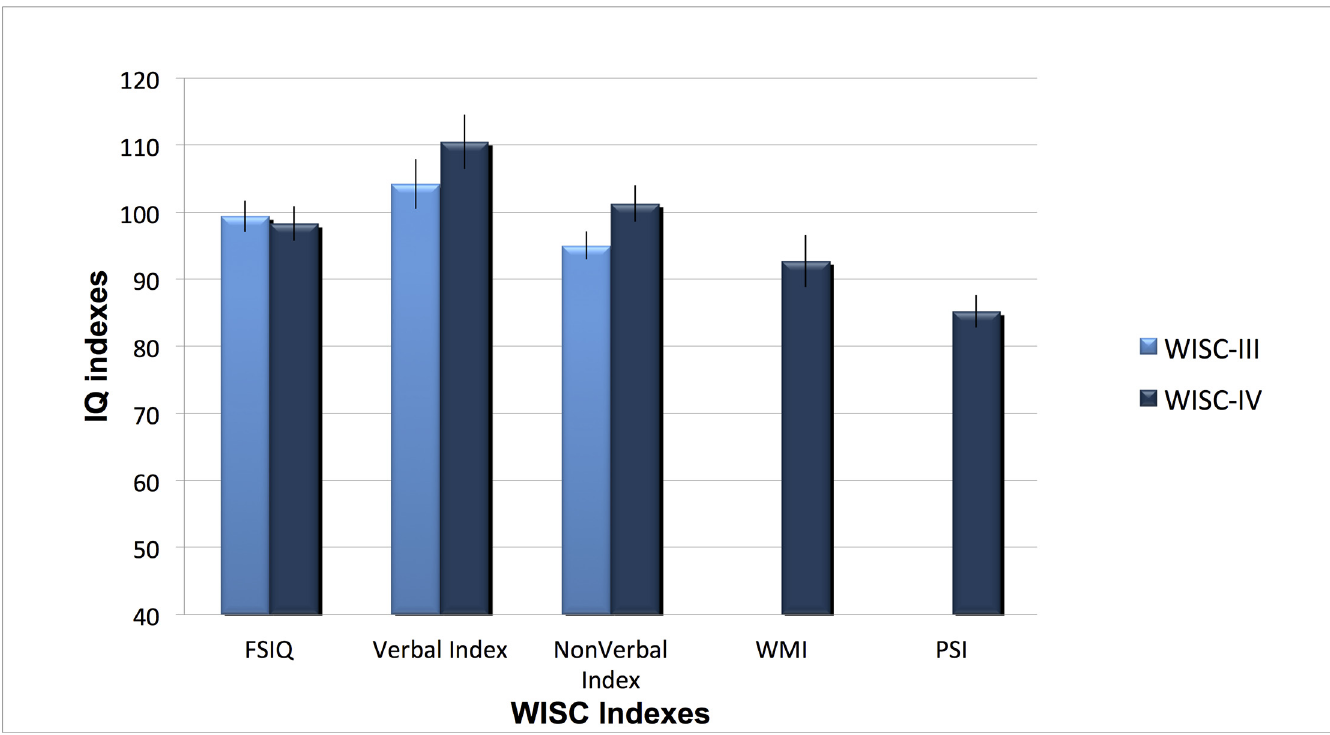
Fig 3. Asperger WISC-III and -IV IQ indexes. Mean standard scores on WISC-III and WISC-IV indexes. FSIQ: Full Scale IQ; Verbal: Verbal Comprehension Index in WISC-IV and Verbal Index in WISC-III); NonVerbal IQ: Perceptual Reasoning Index in WISC-IV and Performance IQ in WISC-III; WMI: WISC-IV Working Memory Index; PSI : WISC-IV Processing Speed Index. Error bars represent standard error from the mean.